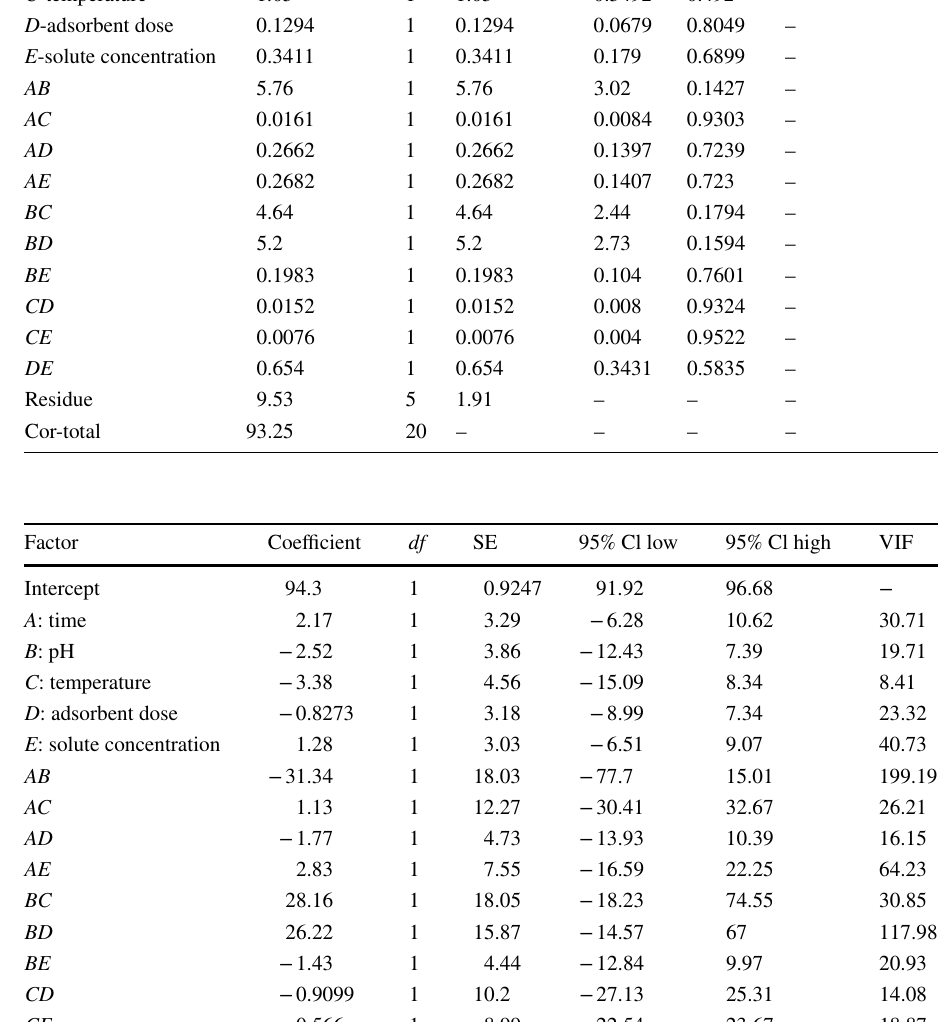
Table 8 ANOVA for response surface 2FI model for malachite green dye removal